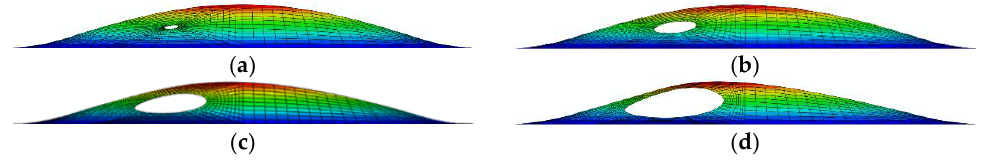
Figure 13. The model shapes of plates with e x / b = 1, β = 3 and BCs of 3S. ( a ) d / b = 0.1; ( b ) d / b = 0.3; ( c ) d / b = 0.5; ( d ) d / b = 0.7.